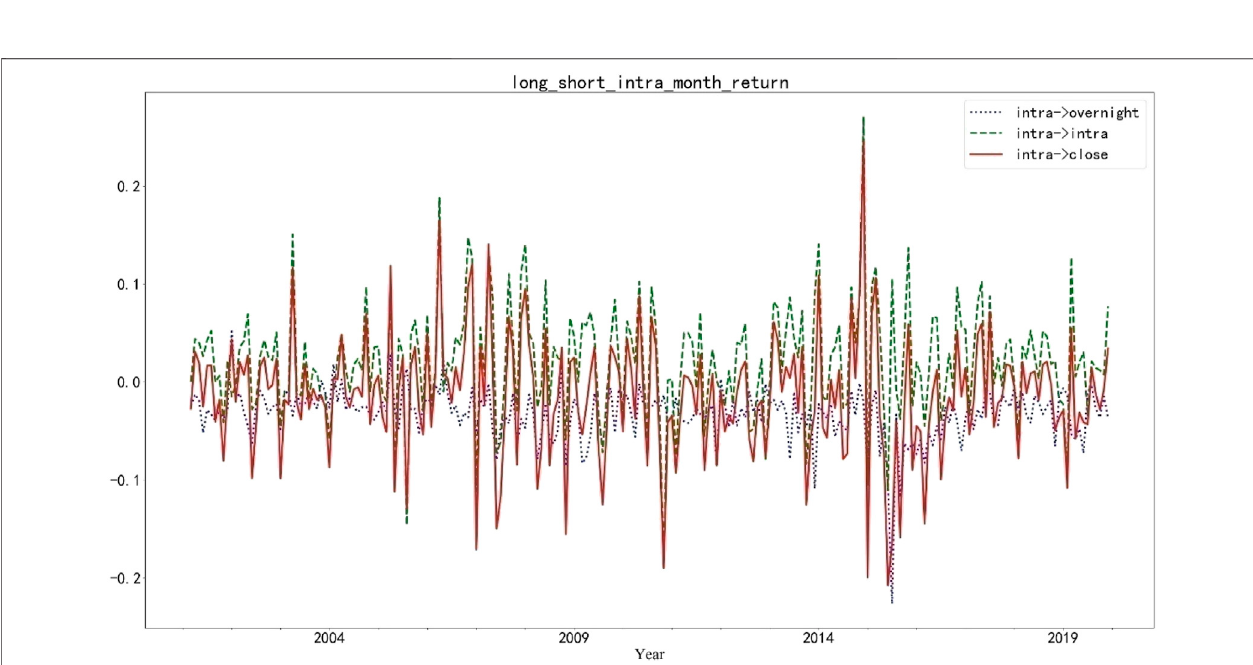
FIGURE2| This fi guredepictstheintraday-overnightpersistenceandreversalpatternreturnforenergyindustrystocks,asreportedinPanelBof Table2 .Theblue dotted curve corresponds to using 1-month lagged intraday returns to forecast the current overnight return. The green dashed curve corresponds to using lagged intraday returns to forecast the current intraday return. The red solid curve corresponds to using lagged intraday returns to forecast the close-to-close return.